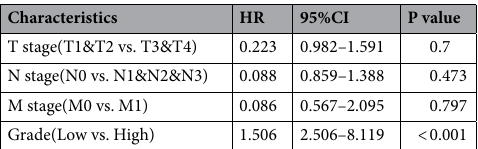
Table 2. PRR11 expression associated with clinicopathologic characteristics (logistic